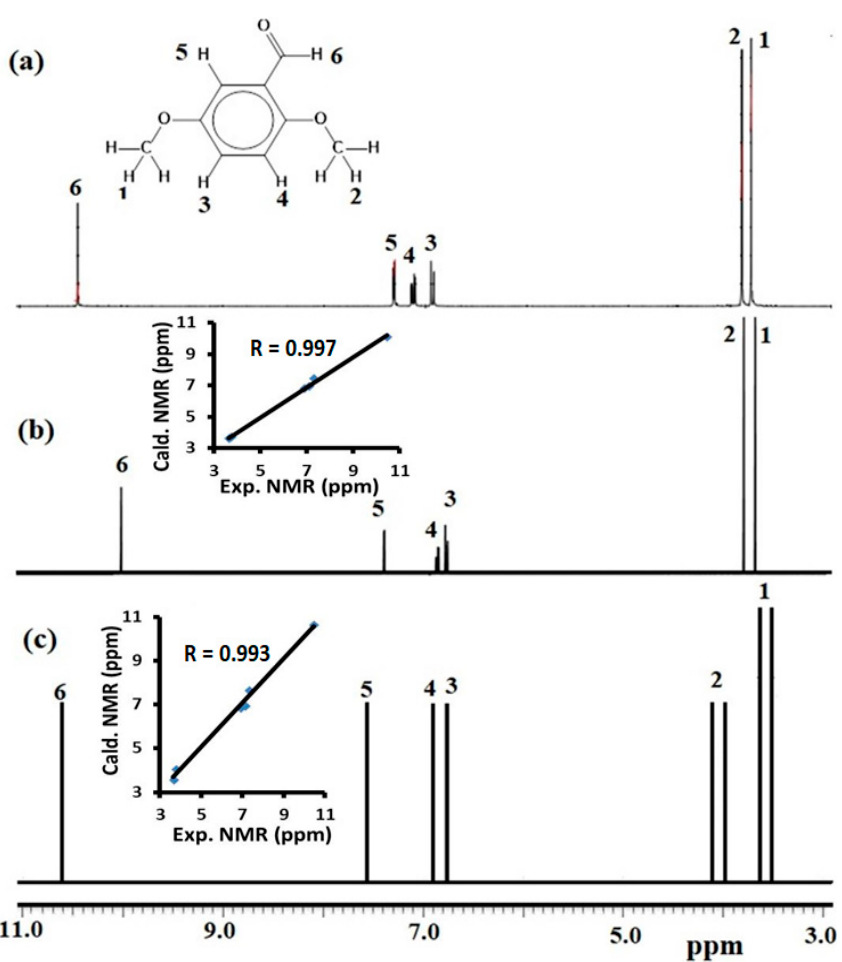
Figure 10. ( a ) Experimental 1 H NMR spectrum of 2,5-dimethoxybenzaldehyde in CDCl 3 . Theoretical ( b ) NMR-DB and ( c ) GIAO-NMR spectrum of 2,5-dimethoxybenzaldehyde in CDCl 3 .